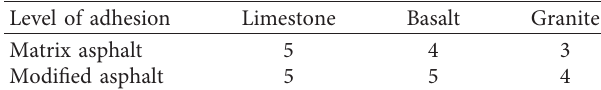
Table 5: Comparison of adhesion